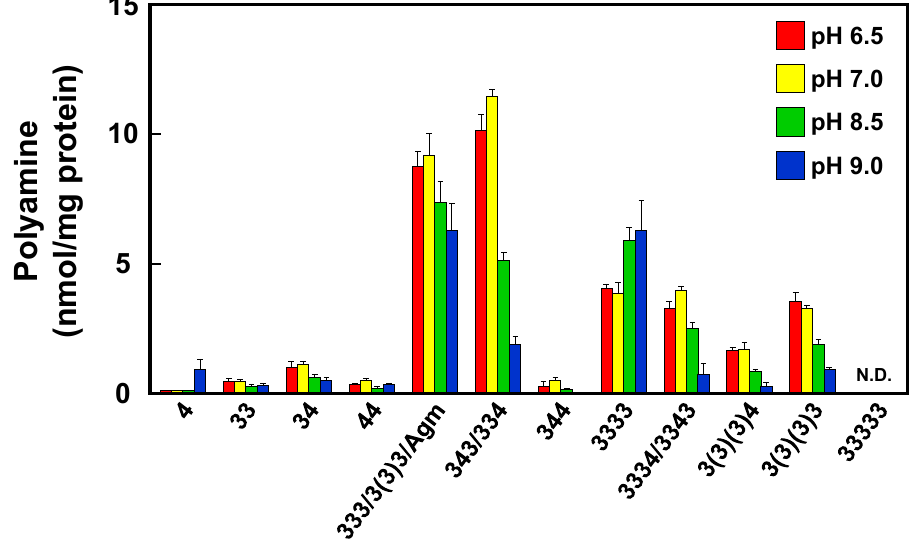
Figure 2. Polyamine content of T. thermophilus HB8 at various pHs. Polyamine content in cells harvested at an A 600 of 0.5 was measured as described in Section 4. HPLC chromatograms are shown in Figure S2A. The contents are shown as means ± standard errors, n = 3. N.D., Not de-